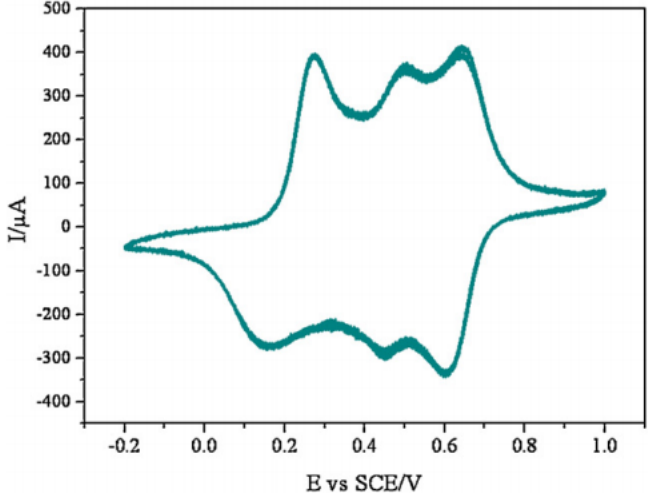
Figure 15. CV measurements of EPU measured in aqueous H 2 SO 4 (1.0 M) at a scan rate of 50 mVs − 1 . From reference [51].